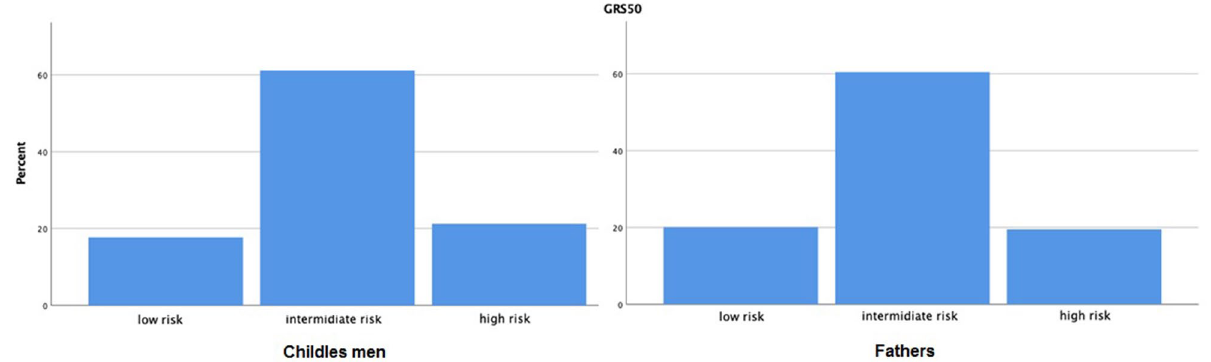
Figure 1. Bar plots representing the distribution of genetic risk groups for cardiovascular disease (GRS 50) between fathers and childless men.